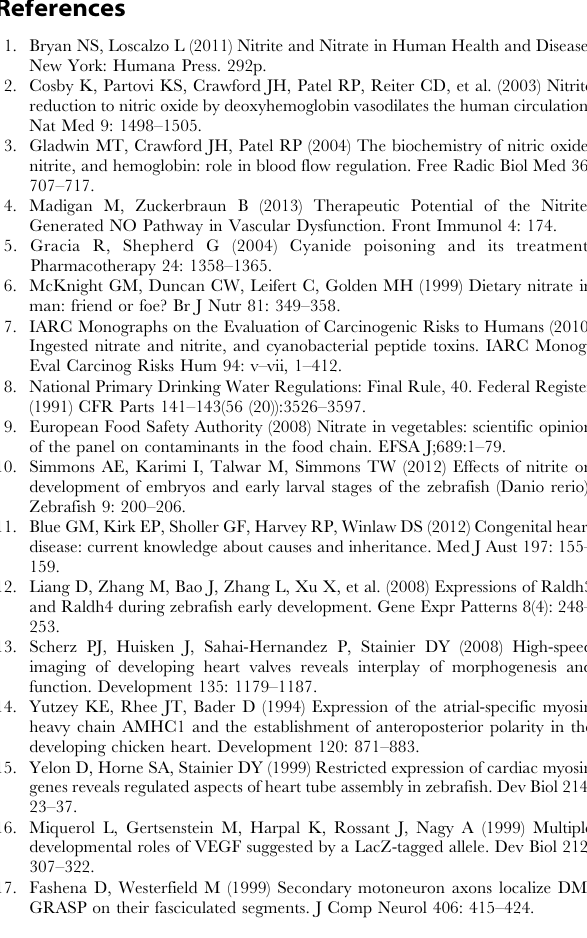
Figure S4 Excessive nitrite exposure did not affect hemody- namics of zebrafish embryos. Embryos were exposed with 100 mg/l nitrite from 10 hpf. After nitrite exposure, embryos derived from Tg(gata1:DsRed) exhibited normal development of red blood cells at 24 (A–D), 36 (E–H) and 48 hpf (I–L), respectively. Consistently, klf2a did not change its expression pattern at 48 hpf after nitrite exposure (M–N). Similarly, embryos derived from Tg(flk1:GFP) displayed normal vessel development at 24 (O-P, O 9 - P 9 ), 36 (Q-R, Q 9 -R 9 ) and 48 hpf (S-T, S 9 -T 9 ), respectively. Panels O 9 -T 9 are the magnification of the region outlined by rectangle in Panel O-T, respectively, showing the normal development of vessels. Figure S5 Nitrite level was dramatically increased in the nitrite- exposed embryos at 24, 36, 48 and 76 hpf, respectively. The values of nitrite level were shown in Y-axis and the different developmental stages were shown in X-axis. **: P , 0.01. Movie S1 Control zebrafish larvae without nitrite exposure had active responses to mechanical stimuli. Control larvae without nitrite exposure at 76 hpf are able to swim. When